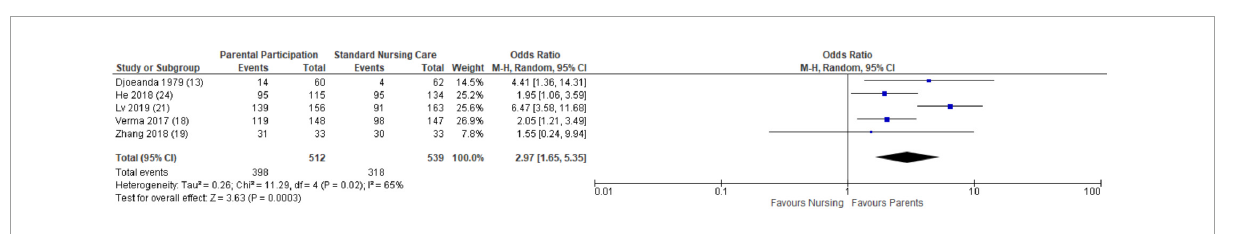
FIGURE5 Forest plot and meta-analysis of the association between parental participation and breastfeeding during hospitalization.